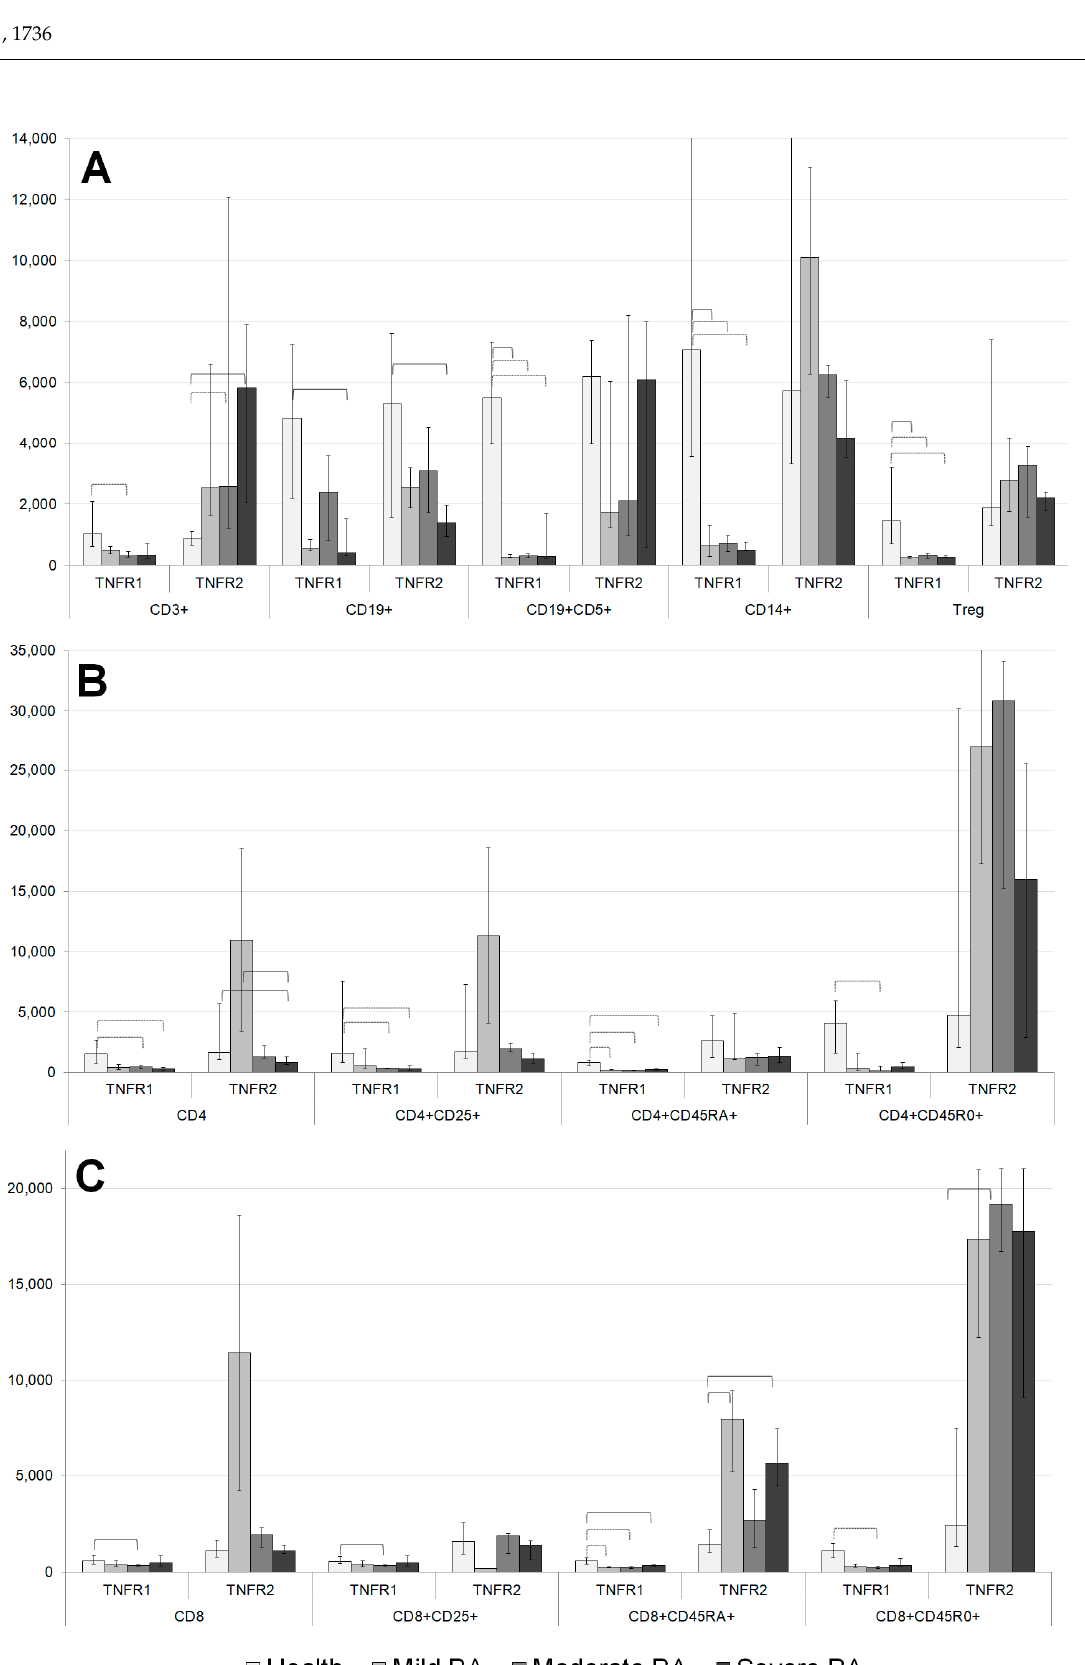
Figure 2. Expression levels of TNFRs in main mononuclear cell subsets ( A ), on CD4+ cells ( B ), and on CD8+ cells ( C ). Solid bracket indicates significant difference with p < 0.05; dotted bracket indicates significant difference with p < 0.005 according to Kruskal–Wallis median test.